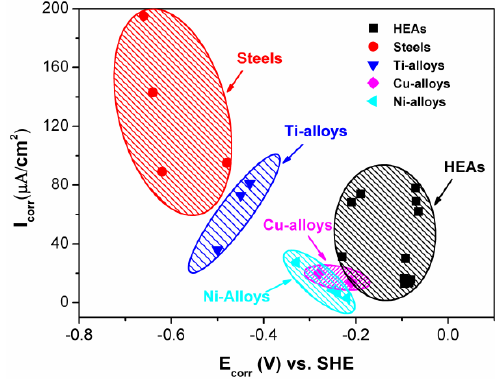
Figure 5. A comparison of the corrosion current density ( i corr ) and corrosion potential ( E corr ) between HEAs and conventional alloys in the 0.5 M H 2 SO 4 solution at room